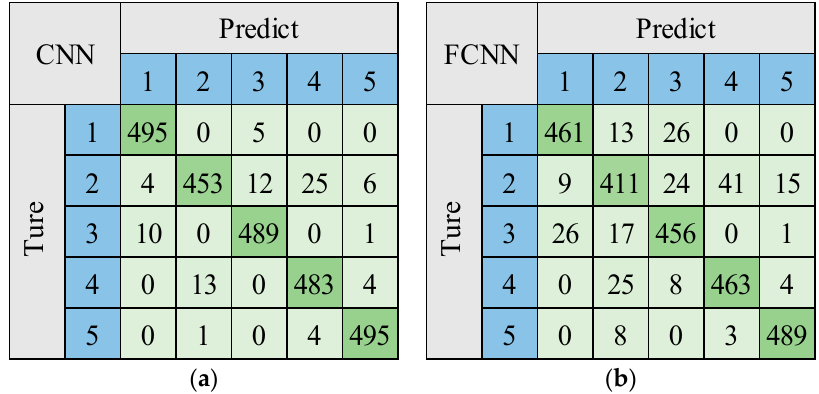
Figure 12. The confusion matrix of CNN and FCNN on training set. ( a ) CNN confusion matrix; ( b ) FCNN confusion matrix.